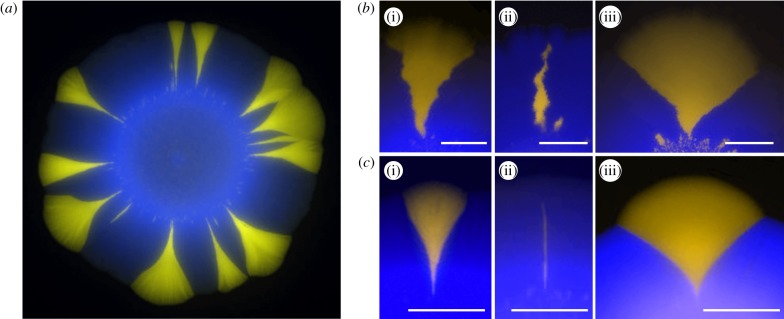
(a) An example of an S. cerevisiae colony with beneficial mutants (yellow) forming sectors. The mutants have a growth rate advantage of s ≈ 10%. (b,c) Fate of mutant cells—experimental counterpart of figure 5. Colonies of E. coli (b) and S. cerevisiae (c) were inoculated using a mixture of a majority of wild-type cells (blue, false colour) and a small number of mutant cells (yellow) with s = 8% (i and ii). Some mutant clones formed large sectors (i), while others (ii) lagged behind the front, became engulfed by wild-type cells and eventually ceased to grow (bubbles). A large growth advantage (s ≈ 16%, iii) caused the sector to ‘bulge out’. All three phenomena are well reproduced by our simulations (c.f. figure 5). In all panels, scale bar, 2 mm. (Online version in colour.)